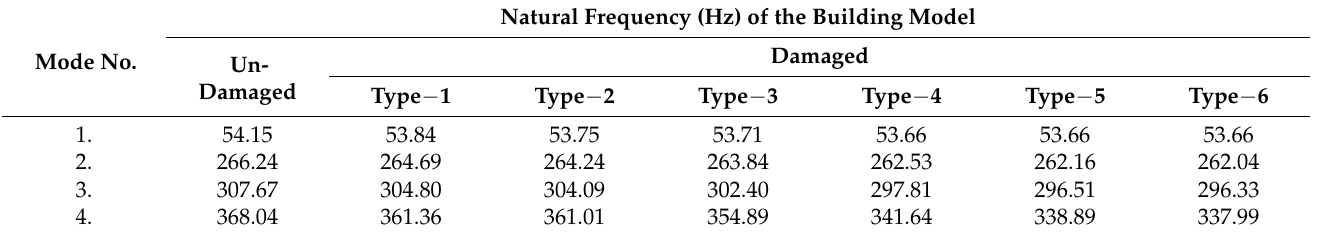
Table 3. Updated natural frequencies (Hz) of undamaged and damaged analytical models.